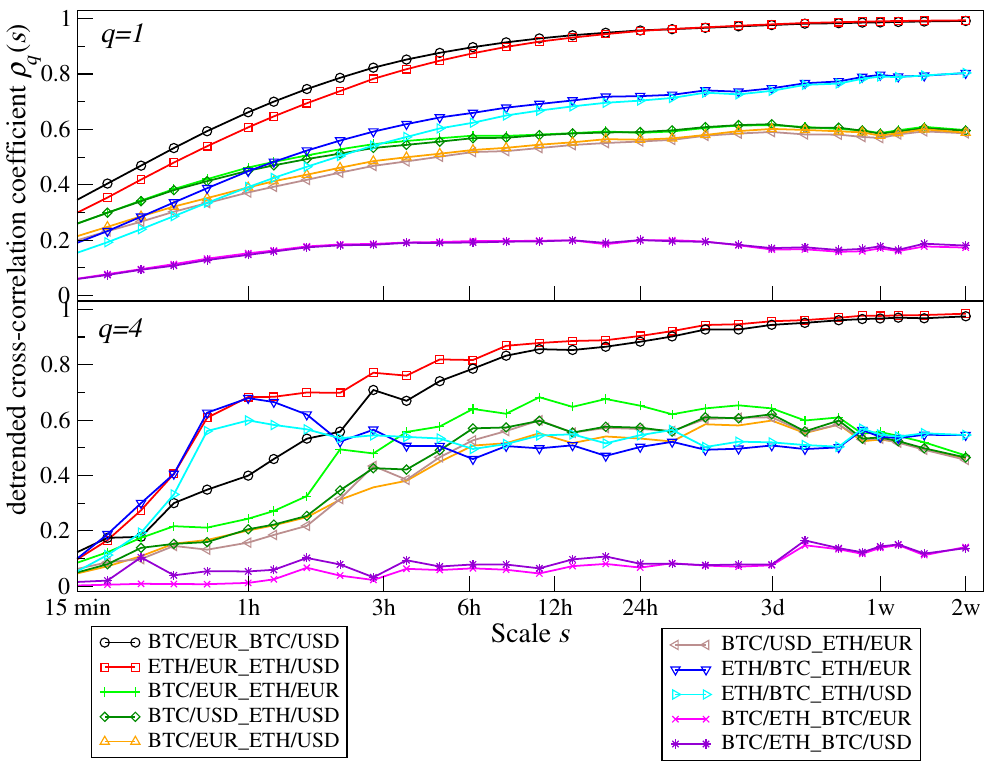
Figure 10. (Color online) q -dependent detrended cross-correlation coefficients ρ q ( s ) for the same ensemble of exchange rates as in Figure 8, shown as functions of the temporal scale s for q = 1 and q =